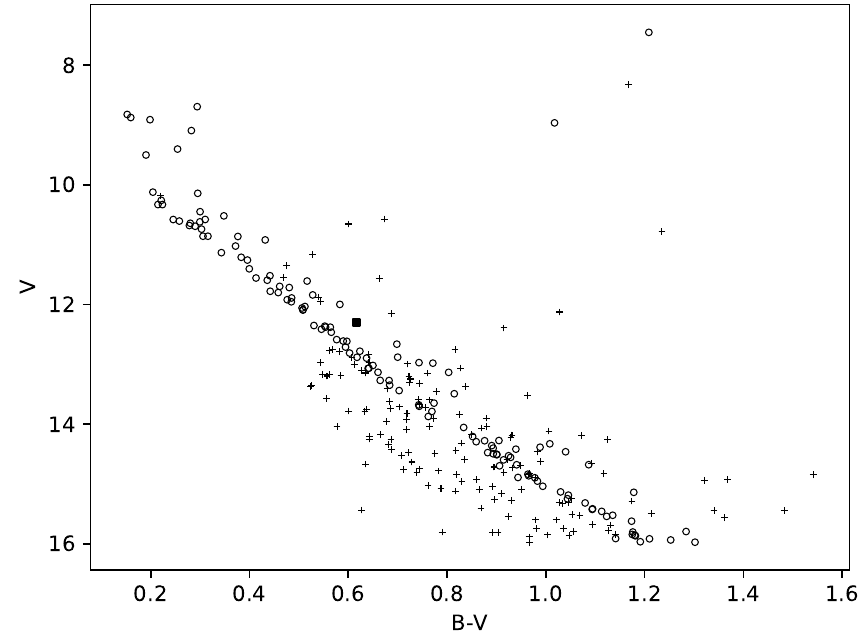
Figure 5. Color–magnitude diagram of the field. Cluster members are plotted as circles and non- members as plus signs. The square marks the location of the eclipsing binary GSC